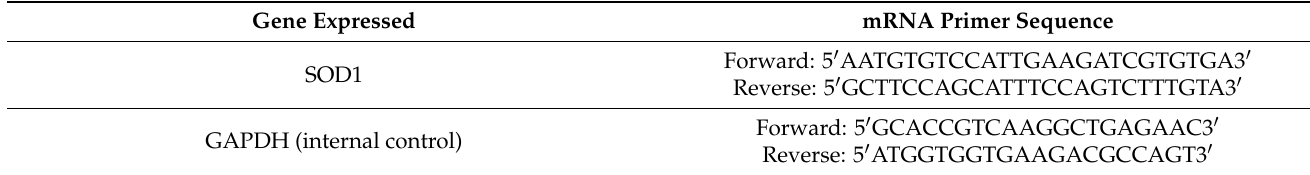
Table 1. Primer sequences for GAPDH and SOD